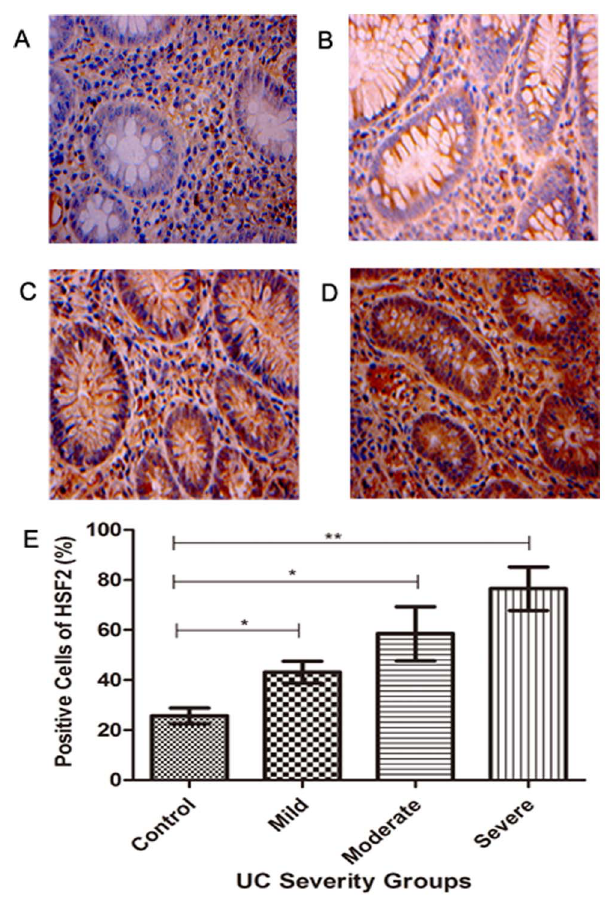
Figure 2. Expression of HSF2 in colonic mucosa tissues of normal control and UC was examined by IHC. A : Representative normal colonic mucosa tissue was negatively stained with anti-HSF2 antibody; B , C and D : Representative UC colonic mucosal tissues of mild, moderate and severe group were positively stained with anti- HSF2 antibody, respectively (magnification, 6 400); E : Positive cell expression of HSF2 was compared. All IHC results were read automatic image analyzer, measured by HPIAS-2000 analytic software. *, p , 0.05; **, p , 0.01.